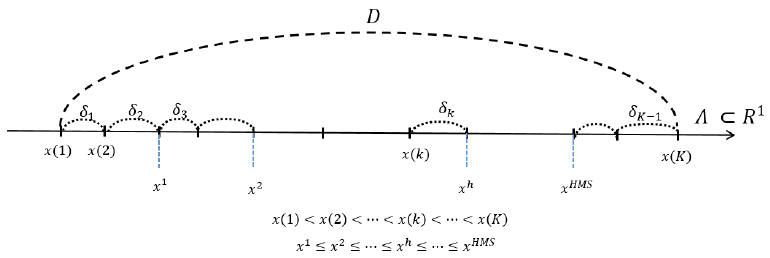
Figure 1. Elements of the candidate set and the subintervals .